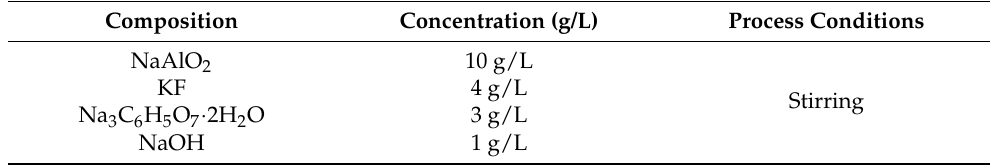
Table 1. Compositions and process parameters of the MAO process.